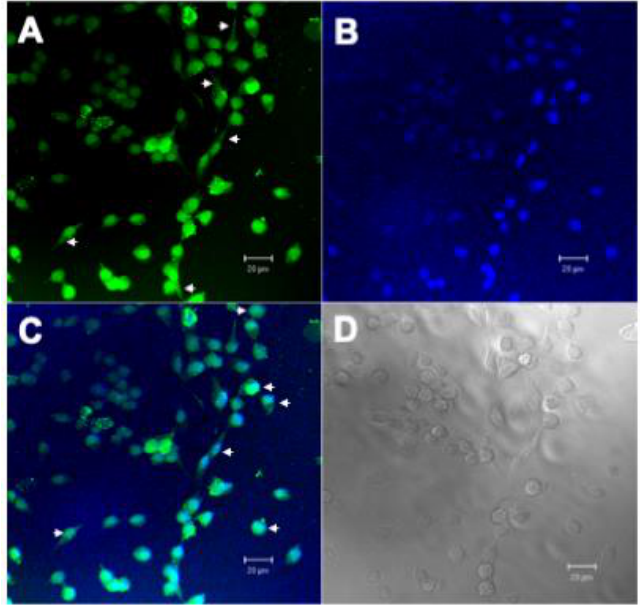
Figure 4. Confocal Microscopy Analysis of L929 with BbKI-AlexaFluor488 . ( A ) L929 cells marked with BbKI conjugated with AlexaFluor 488 (green), showing cell surface localization (arrowheads), ( B ) L929 nuclei stained with 4′,6 -Diamidino-2-phenylindole dihydrochloride , DAPI (blue), ( C ) overlay of images with BbKI nuclear localization (arrowheads) in L929 cells and ( D ) differential interference contrast (DIC) microscopy of L292 cells. Scale bar: 20 µm.